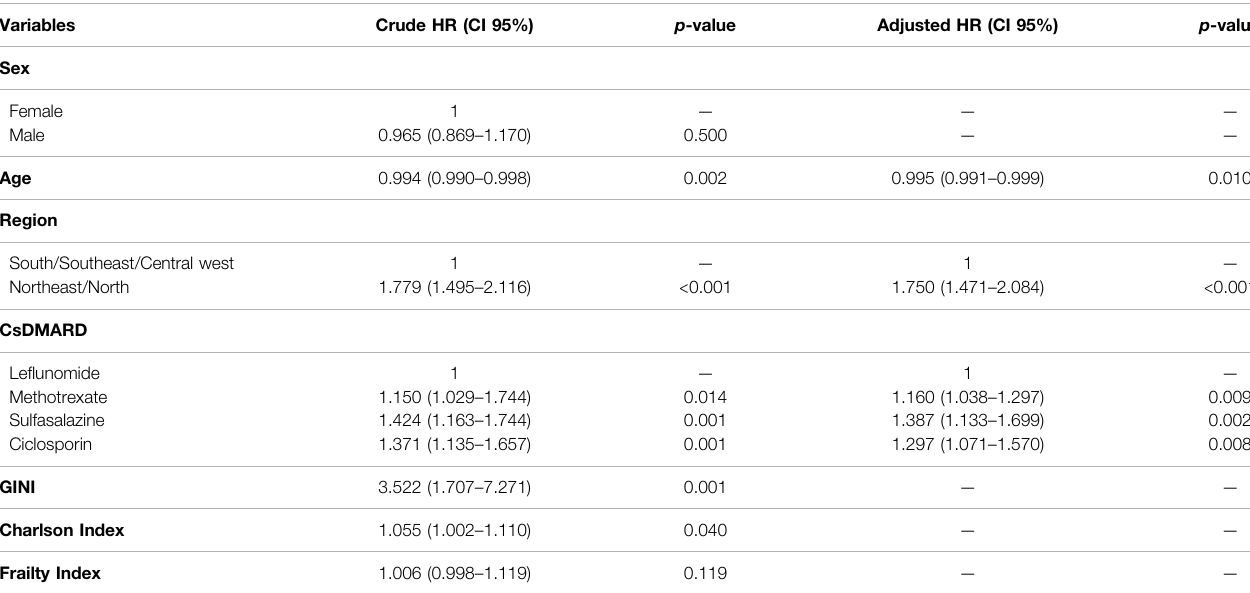
TABLE 5 | Predictors of treatment discontinuation at 12 months of follow-up.